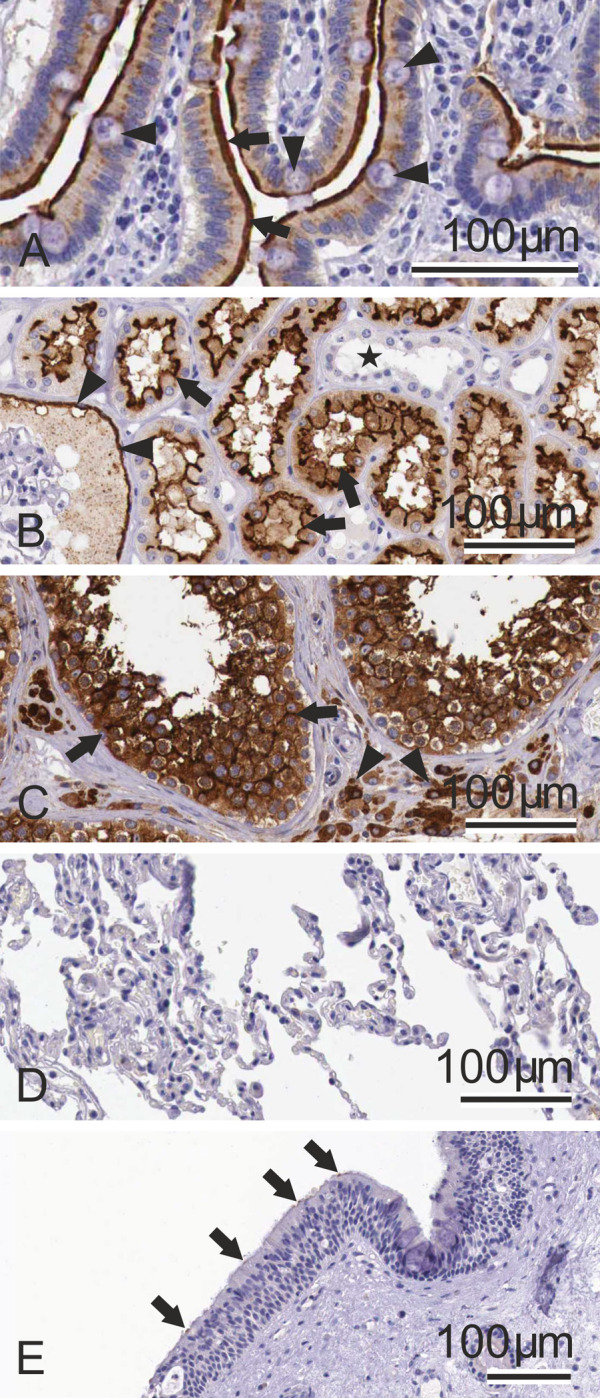
Immunohistochemical localization of ACE2 protein in selected human tissues.In the duodenum (A), the protein is most strongly localized to the apical plasma membrane of absorptive enterocytes (arrows). The goblet cells (arrowheads) show weaker apical staining. Intracellular staining is confined to the absorptive enterocytes. In the kidney (B), ACE2 shows strong apical staining in the epithelial cells of the proximal convoluted tubules (arrows) and Bowman´s capsule epithelium (arrowheads). The distal convoluted tubules are negative (asterisk). The testis specimen (C) shows strong immunostaining in the seminiferous tubules (arrows) and interstitial cells (arrowheads). The lung sample (D) is negative. In the nasopharyngeal mucosa (E), ACE2 signal is very weak and only occasional epithelial cells show weak signals (arrows). Immunostained specimens were taken from the Protein Expression Atlas (https://www.proteinatlas.org/).